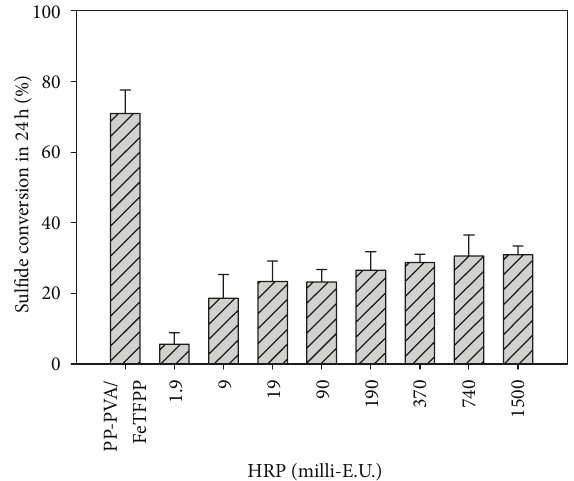
Figure 4: Comparison between the biomimetic catalysis and horseradish peroxidase (HRP). The indicated E.U. of HRP was incubated in a final volume of 1mL of 25mM buffer pH 5, 10mM NaHS,and8.8 mMH 2 O 2 .PP-PVA/FeTFPPcatalysisoccurredinthe same conditions described in Figure 3 ( 𝑛 = 5